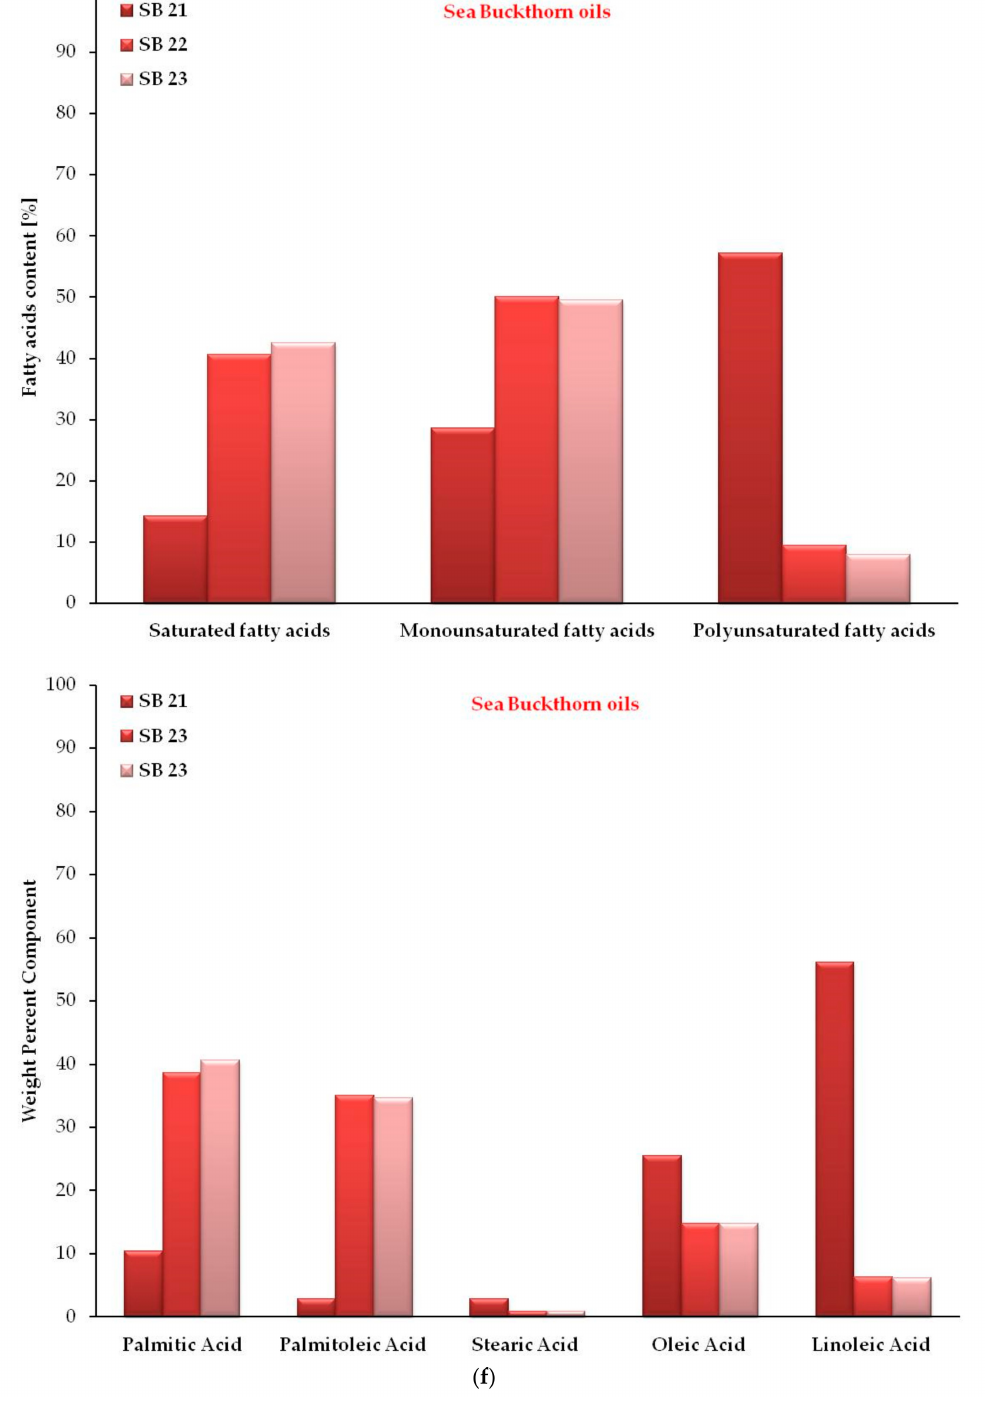
Figure 2. Composition of total saturated, monounsaturated, and polyunsaturated fatty acids from the oil samples which was determined by GC-FID and percentage distribution of fatty acids ( a ) sunflower; ( b ) sesame; ( c ) hemp; ( d ) walnut; ( e ) linseed; ( f ) sea